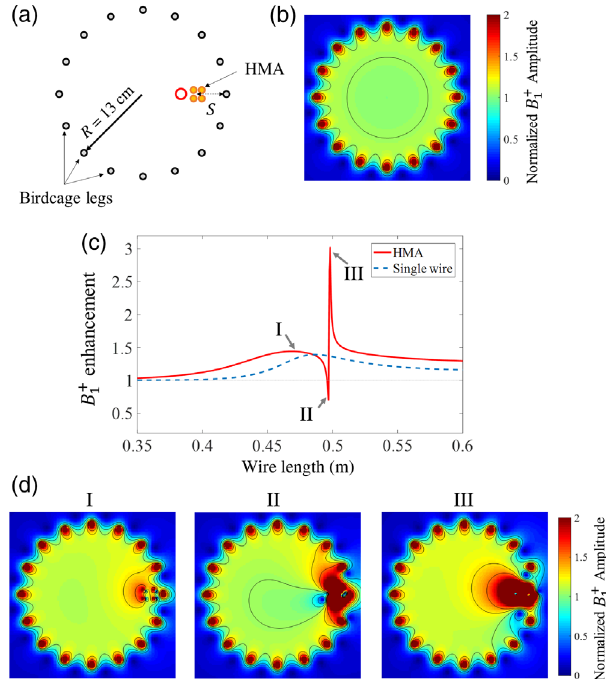
FIG. 3. (a) Sketch of the considered geometry for the insertion of the HMA inside a birdcage model. The birdcage is composed of 16 legs on a 26-cm-diameter cylinder. The legs are 28 cm long and the HMA is located at S ¼ 2 . 5 cm from the first leg. Red circle denotes the ROI for the B þ 1 enhancement plot. (b) B þ 1 amplitude calculated in a quadrature driven empty birdcage. (c) B þ 1 enhancement in the ROI with respect to the empty birdcage in function of the HMA length. The solid red line corresponds to the HMA and the blue dashed line corresponds to the single wire case. (d) Calculated B þ 1 amplitude maps with the HMA for three lengths of interest shown in (c), respectively, 47.5, 49.6, and 49.8